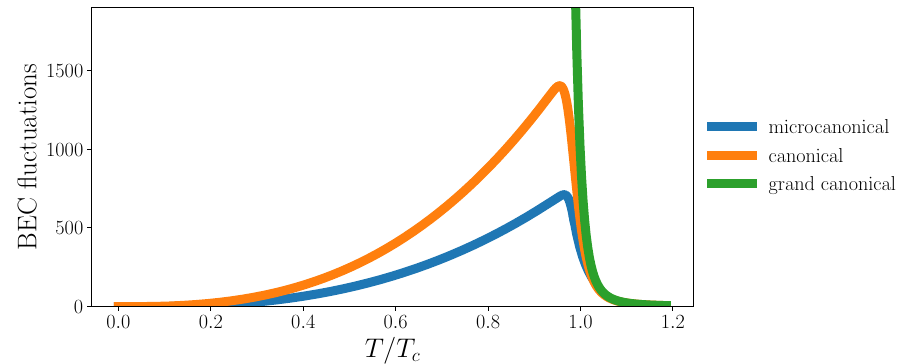
Figure 1: Illustration of the variance of the number of ground state atoms in three statistical ensembles as a function of temperature T in units of the canonical critical temperature T . When the temperature of an ultracold Bose gas is lowered towards c T a grand canonical ensemble calculation predicts unphysically large fluctuations c (green line). A canonical ensemble calculation does not suffer from this problem and predicts a peak in fluctuations below T (orange line). These fluctuations de- c crease as the number of atoms in the thermal states declines for lower temperatures. A microcanonical calculation (blue line) shows the same features but predicts quan- titatively lower peak fluctuations which can be shifted in temperature with respect to the canonical result. This sketch is based on a numerical calculation for N = 1000 non-interacting atoms in a three dimensional symmetric harmonic